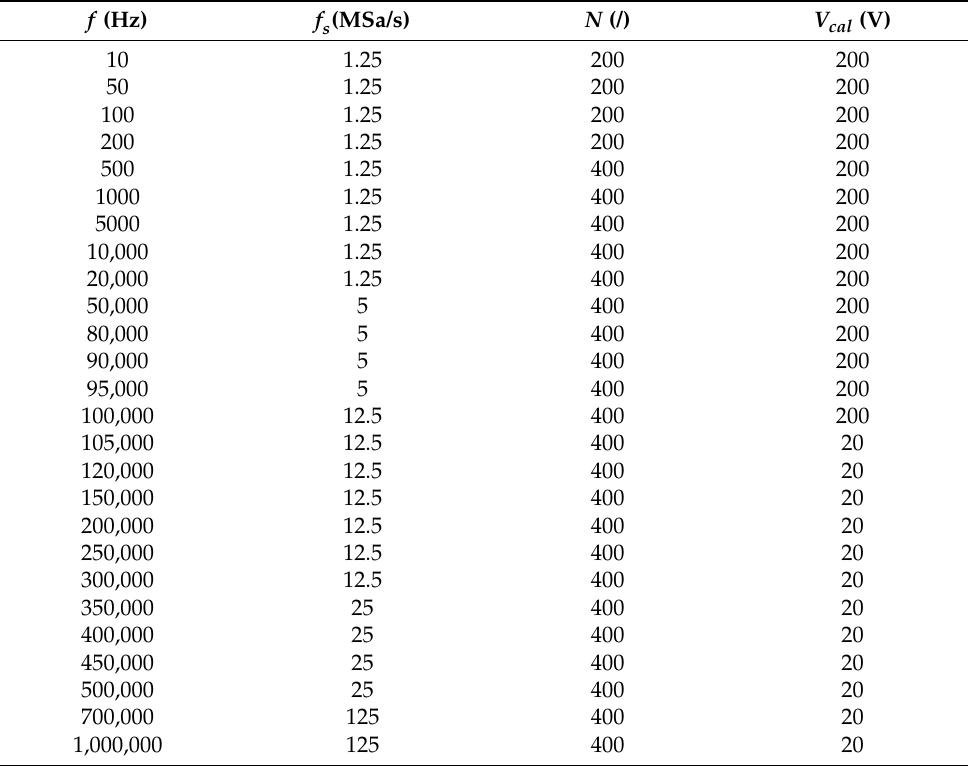
Table 4. Main settings of the frequency sweep